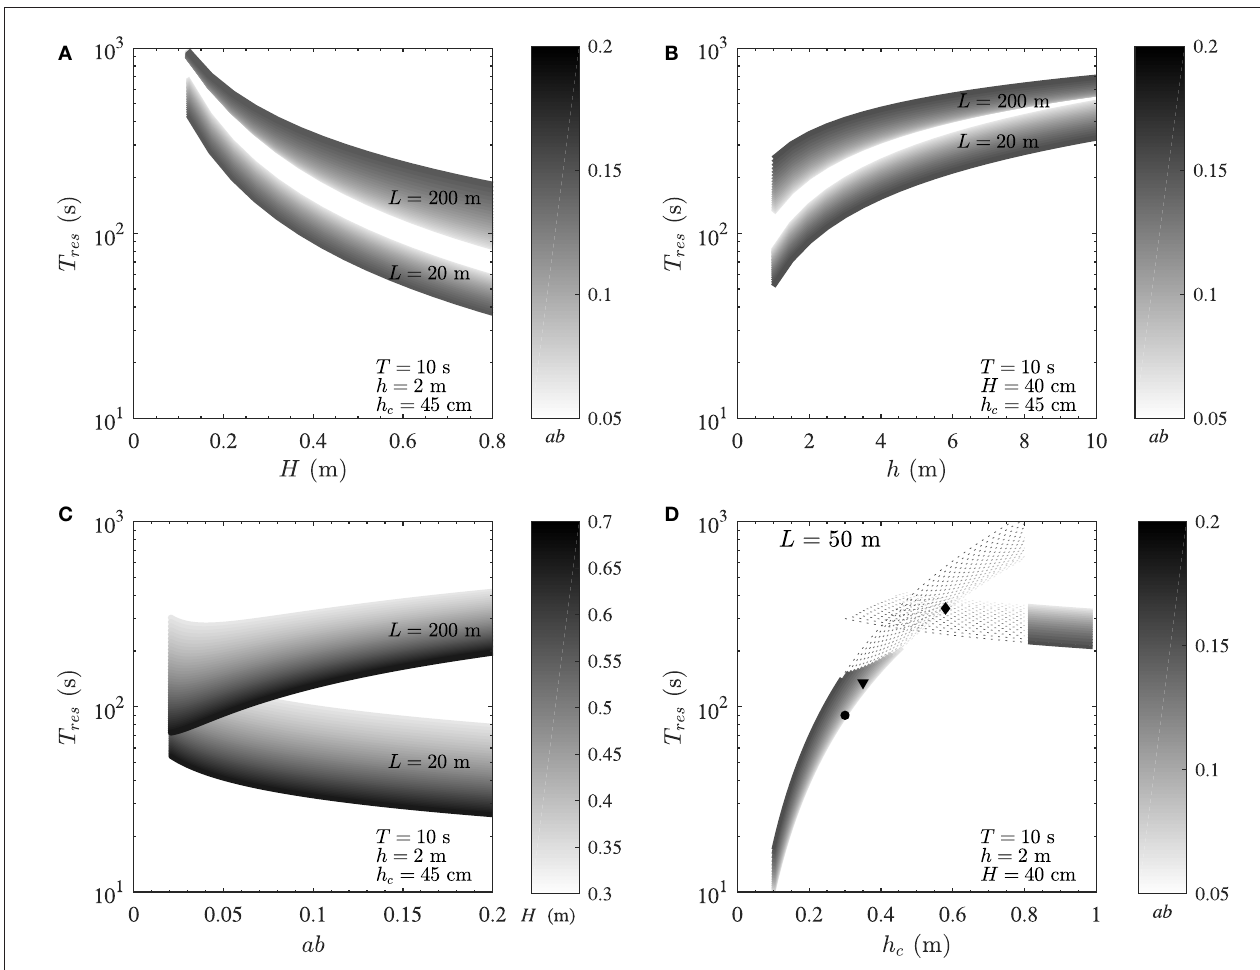
FIGURE 5 | Variation of residence time with wave and canopy properties for a typical seagrass meadow. (A) Residence time decreases with increasing wave height ( H ), and (B) increases with water depth ( h ) (in both mixing- and advection-dominated canopies). (C) While residence time decreases with canopy density ( ab ) in short, mixing-dominated canopies, it increases in long, advection-dominated canopies. (D) Increasing canopy height enhances residence time until reaching a threshold value after which T res decreases with increasing canopy height ( h c ). The black diamond, triangle, and circle represent values of T res in the canopies shown in Figures 2A–C , respectively. Constant variables for calculations of each plot are indicated in the